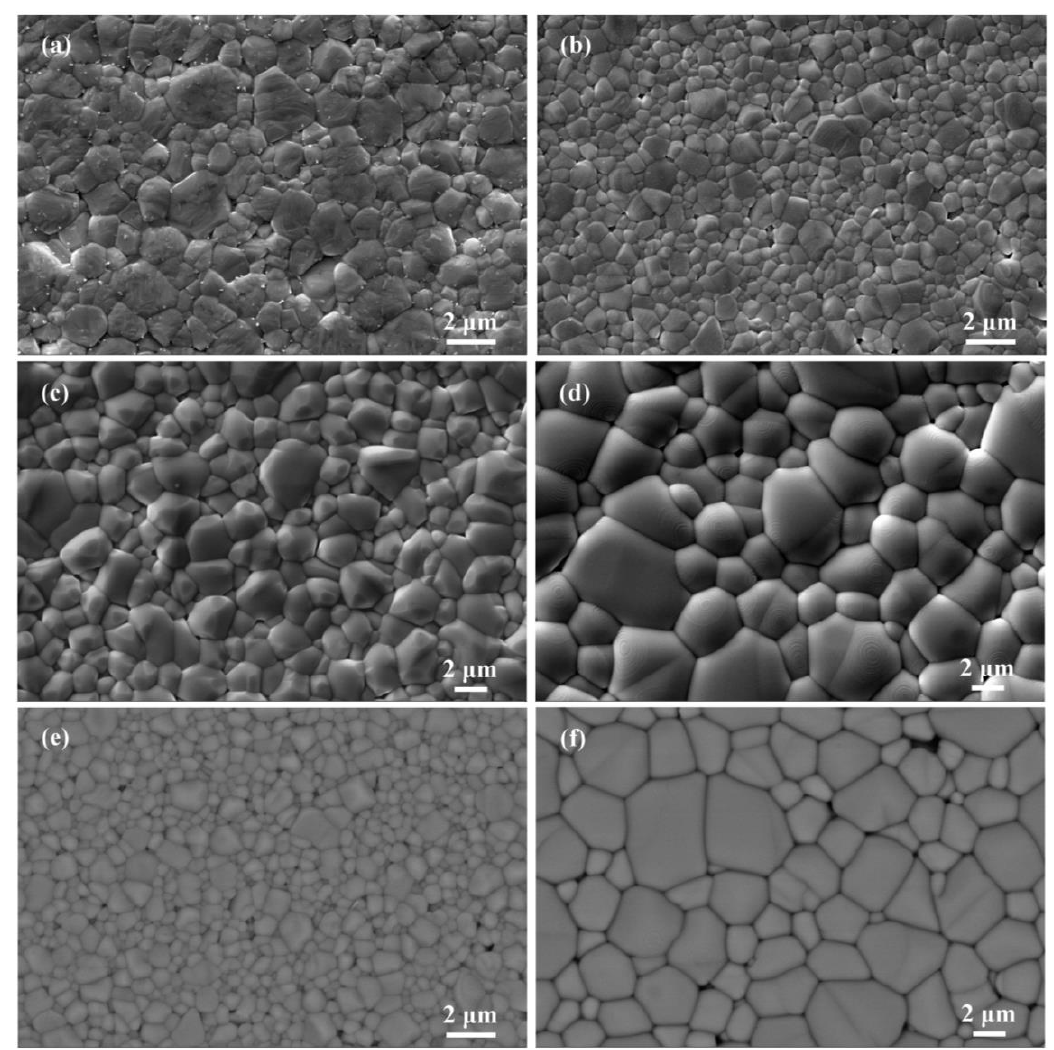
Figure 1. SEM images of (Ba 1− x Sm x )(Ti 0.99 Mn 0.01 )O 3 (BSTM) ceramics with ( a ) x = 0.02, ( b ) 0.04, ( c ) 0.06, and ( d ) 0.07, and BSE images of BSTM ceramics with ( e ) x = 0.04 and ( f )